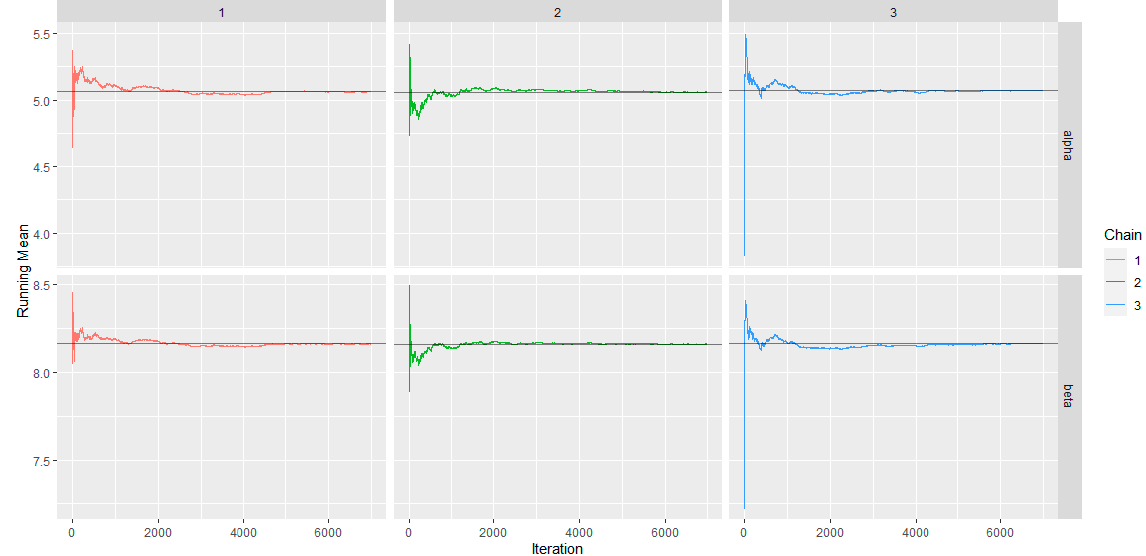
Figure 12. The AP distribution posterior parameters ergodic mean plots. The rapid decay of the autocorrelation plots, as shown in Figure 13, suggests good mixing of the chains and the convergence of the MCMC algorithm.